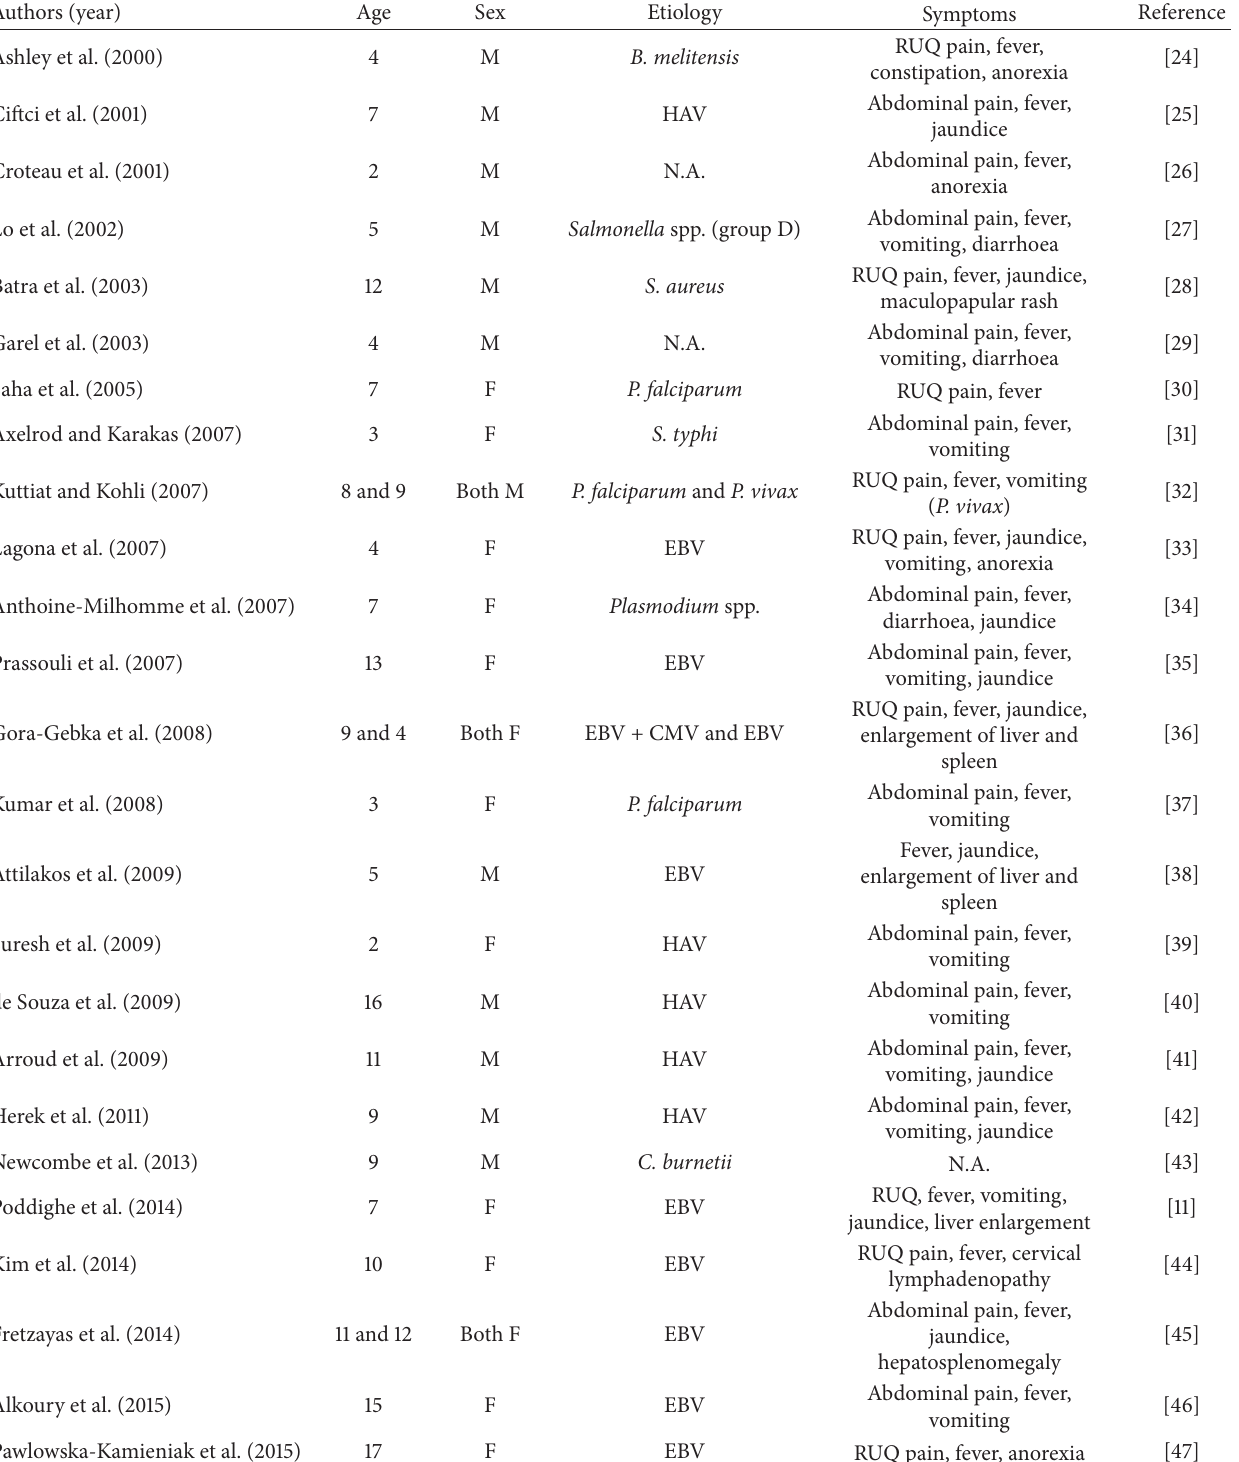
Table 1: Case reports of pediatric AAC in previously healthy children since